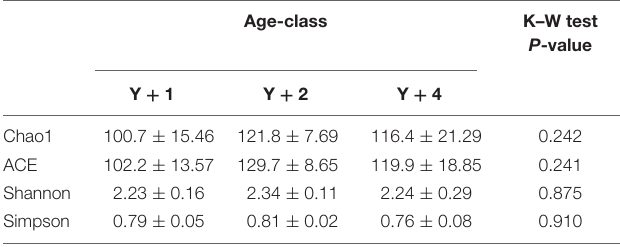
TABLE 2 | Species richness estimates (Chao1 and ACE) and diversity indexes (Shannon and Simpson) of 10 fish of 1-, 2-, and 4-year-old (Y + 1, Y + 2, and Y + 4, respectively).